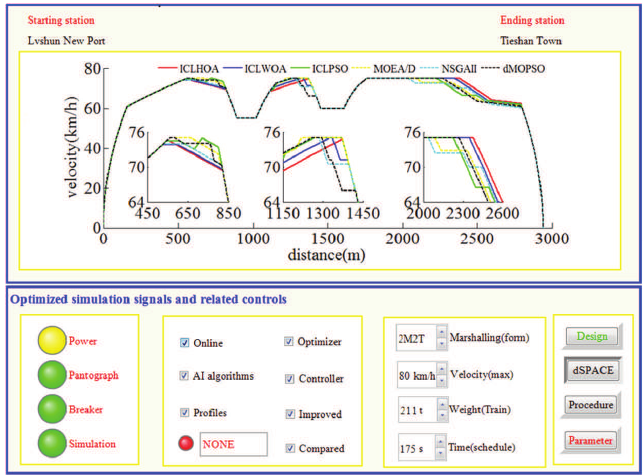
Figure 29. The velocity ideal trajectory profile obtained by different algorithms in RCL-HILS (peak time